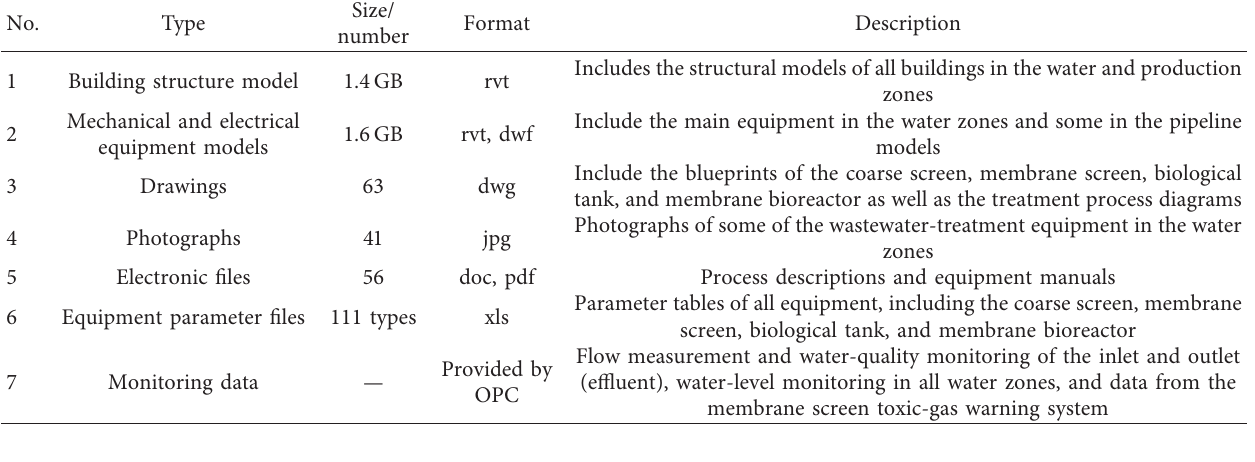
Table 1: Types of information in the O&M model of the